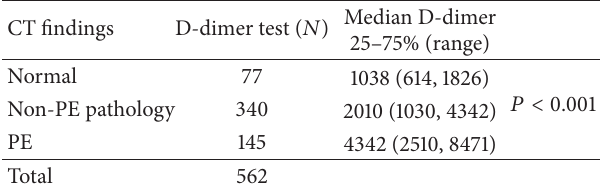
Table 4: CT findings—D-dimer.